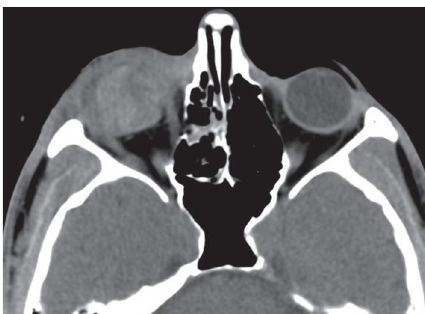
Figure 3: Open globe injury in a 53-year-old woman. Axial unenhanced CT image showing hemorrhage in posterior chamber of the right eye.